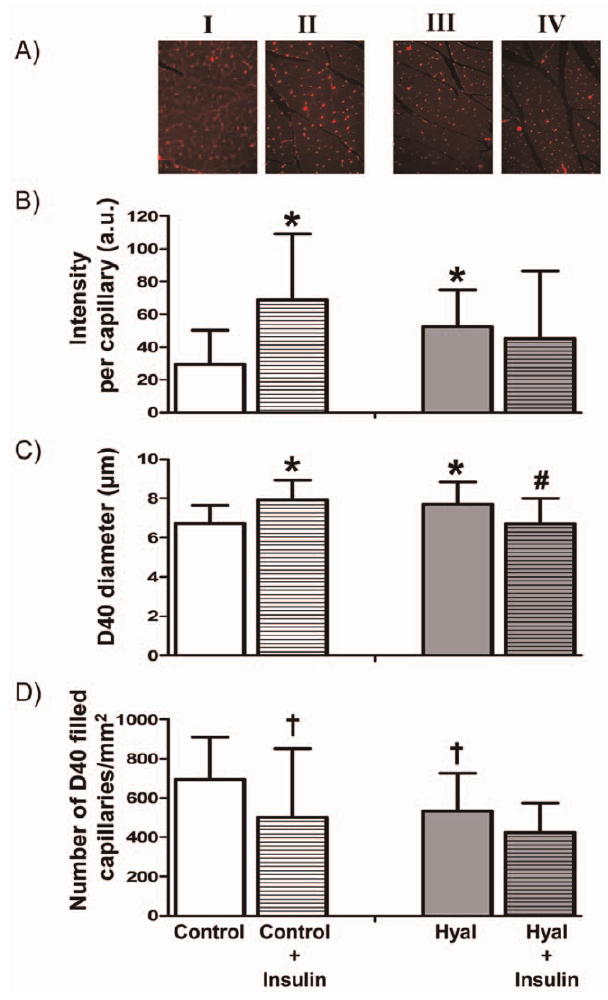
Figure 3. Typical examples of histological cross sections of rat hindlimb muscles at baseline in control rats (1 hour after saline; I, n=18 slides), 30 minutes after insulin administration in control rats (II, n=13 slides), 1 hour after a bolus of hyaluronidase (III, n=17 slides) and 30 minutes after insulin in hyaluronidase treated rats (IV, n=11 slides) ( A ) . In each slide the total intensity (B) and diameter (C) of each tracer filled capillary were determined, as well as the number of filled capillaries (D) (see Methods). In muscles of rats in which no tracer was infused (n=12), the number of counted capillaries was 102 and total intensity in these capillaries was 18.8; data in panels B and D are corrected for these values. *, P , 0.05 versus control baseline (unpaired student’s t-test); { , P , 0.05 versus control baseline (Mann-Whitney U test); # , P , 0.05 versus hyaluronidase baseline (unpaired student’s